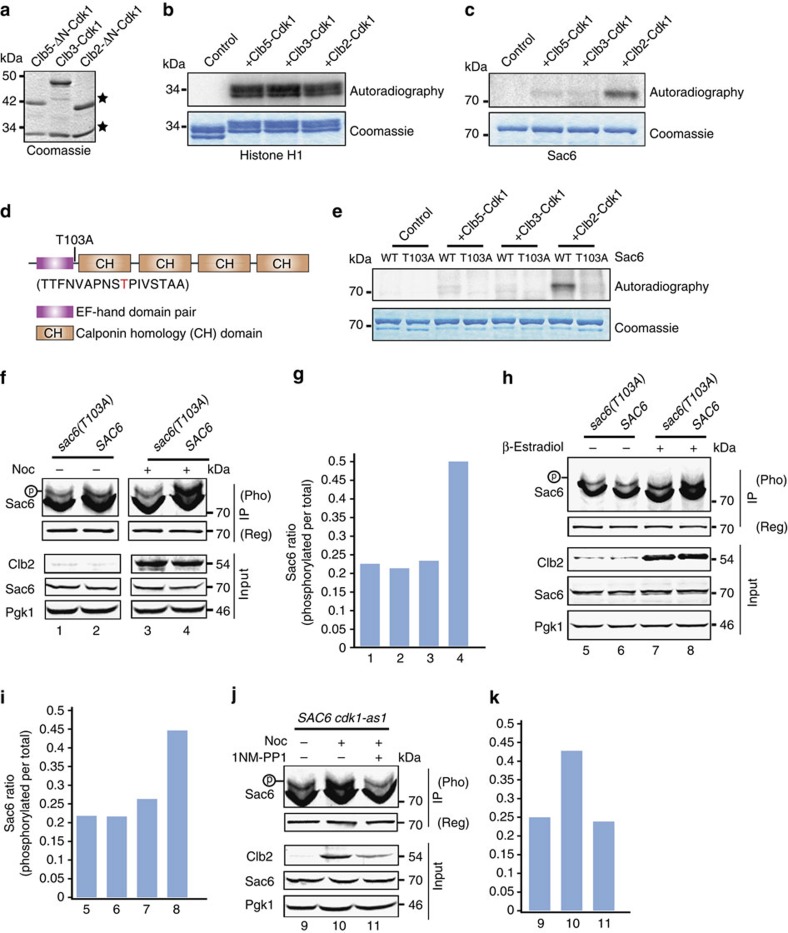
Phosphorylation of fimbrin (Sac6) by Cdk1.(a) Purification of cyclin–Cdk1 complexes from yeast. Coomassie blue staining shows Clb5–ΔN–Cdk1, Clb3–Cdk1 and Clb2–ΔN–Cdk1 purifed from yeast. (b) Normalization of kinase activity using histone H1. An amount of 2 μg of histone H1 was incubated with 12 ng of Clb5–ΔN–Cdk1, 11 ng of Clb3–Cdk1 and 6.5 ng of Clb2–ΔN–Cdk1 in the presence of [γ32P]-ATP at room temperature (25 °C) for 20 min. (c) Sac6 phosphoryaltion using same H1 kinase activities of cyclin–Cdk1 complexes. An amount of 1 μg of Sac6 protein was incubated with 6 ng Clb5–ΔN–Cdk1, 5.5 ng of Clb3–Cdk1 and 3.25 ng of Clb2–ΔN–Cdk1 in the presence of [γ32P]-ATP at room temperature for 20 min. (d) Identification of Sac6 residue T103 as a Clb2–Cdk1 target using mass spectrometry. (e) Clb2–ΔN–Cdk1 phosphoryaltes WT Sac6 but not Sac6-T103A. An amount of 1 μg Sac6 or Sac6-T103A was incubated with different cyclin–Cdk1 complexes. Phosphorylation was analysed by autoradiography following SDS–PAGE in b,c and e. (f,g) Asynchronous and nocodazole arrested SAC6 and sac6(T103A) cells were collected, respectively, and subjected to immunoprecipitation (IP). Proteins were resolved on either regular or phosphate-affinity (Phos-tag), and blotted using Sac6, metaphase cyclin Clb2 and loading control Pgk1 antibodies. Numbers in g correspond to lane numbers in f. (h,i) SAC6 and sac6(T103A) cells, carrying ADH1pr-GAL4BD-hER-VP16 (GEV), were induced with 100 nM of β-estradiol, collected and subjected to IP. (j,k) SAC6 cells were collected from asynchronous and nocodazole arrested cells. Nocodazole arrested cells were treated with or without additional 1-NM-PP1 before being subjected to IP. The intensity ratio of phospholyated Sac6 species to total Sac6 in f,h and j (upppest panel, Phos-tag gel) was analysed and is shown in the graphs g,i and k, respectively. Symbol (p) indicates the phosphorlyated species of Sac6 on phos-tag gel in f,g,i and k.